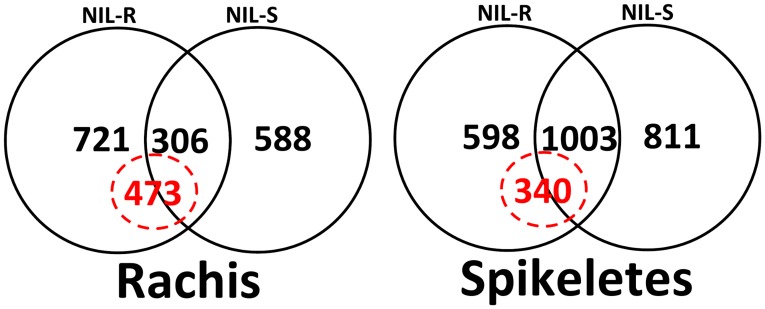
Venn diagram differentially accumulated metabolites (P<0.05) detected in wheat NILs with resistant and susceptible alleles of Fhb1 upon F. graminearum or mock inoculation.Numbers in dotted circle =  number of resistance related induced metabolites (RRI).